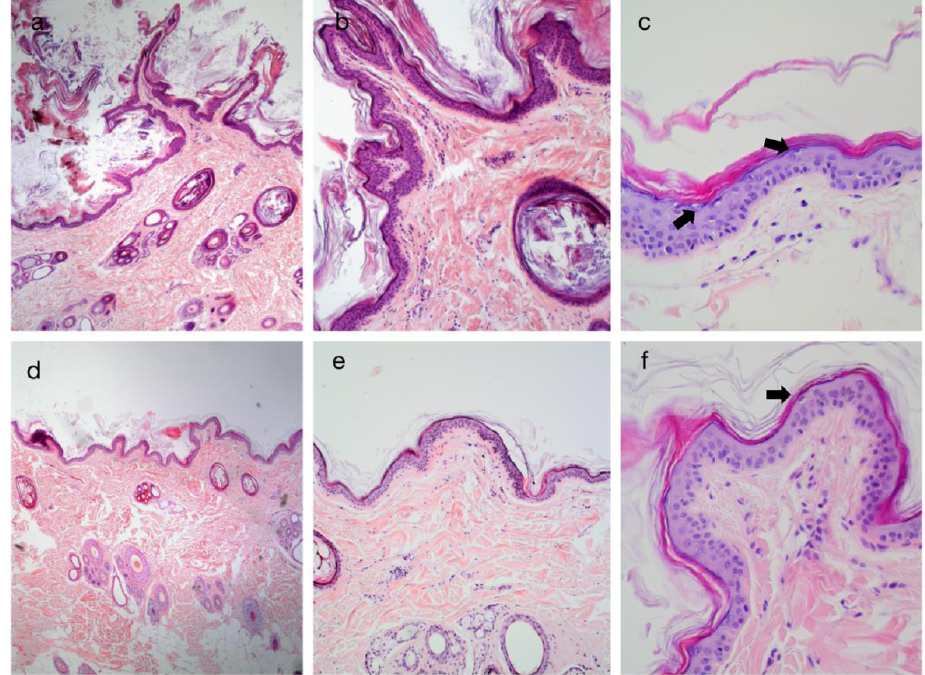
Figure 2. Histopathological changes in skin biopsies in a golden retriever with autosomal recessive congenital ichthyosis (ARCI), before ( a – c ) and after treatment ( d – f ) with isotretinoin. Note the diffuse and severe laminar orthokeratotic hyperkeratosis in the stratum corneum in picture ( a ) ( × 4), ( b ) ( × 10) and ( c ) ( × 40). After treatment with isotretinoin, keratin was not so abundant, as shown in pictures ( d ) ( × 4), ( e ) ( × 10) and ( f ) ( × 40), and had a more typical basket-weave appearance (pictures e , f ). In picture ( c ) ( × 40), there is a moderate number of scattered vacuolated keratinocytes (arrows) in the epidermis, while in picture ( f ) (×40), their number is decreased.